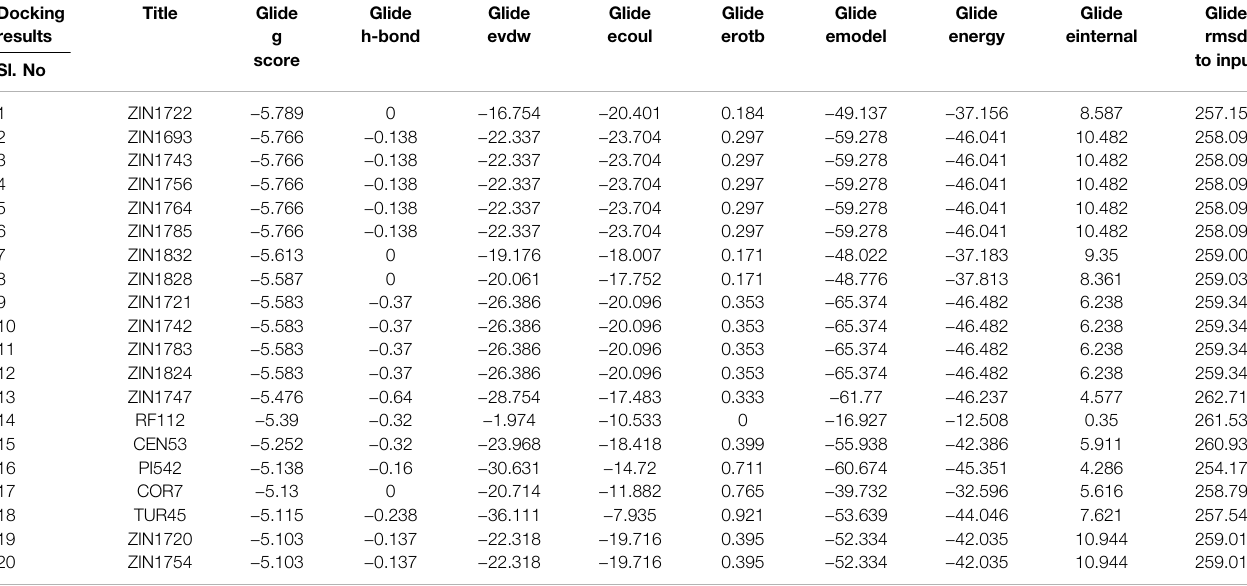
TABLE 1 | Docking score and ranking of the compounds evaluated through Glide Docking module. Docking